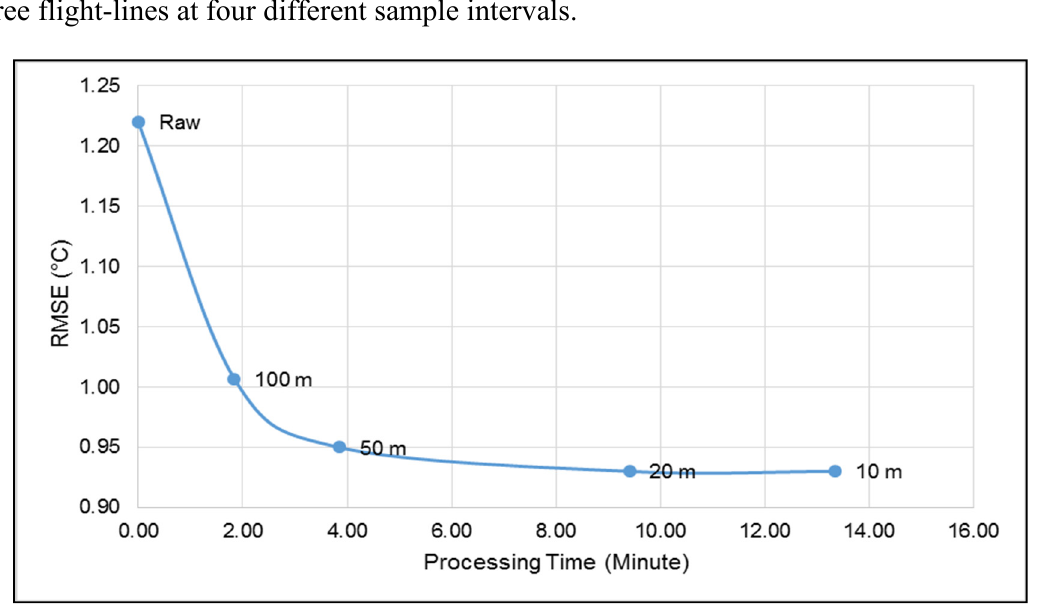
Figure 9. A comparison of average radiometric accuracy vs. average processing time for three flight-lines at four different sample